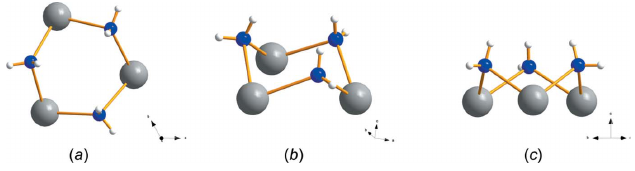
Figure 3 The trimeric unit Na 3 (H 2 O) 3 viewing from different directions ( a , b and c ).